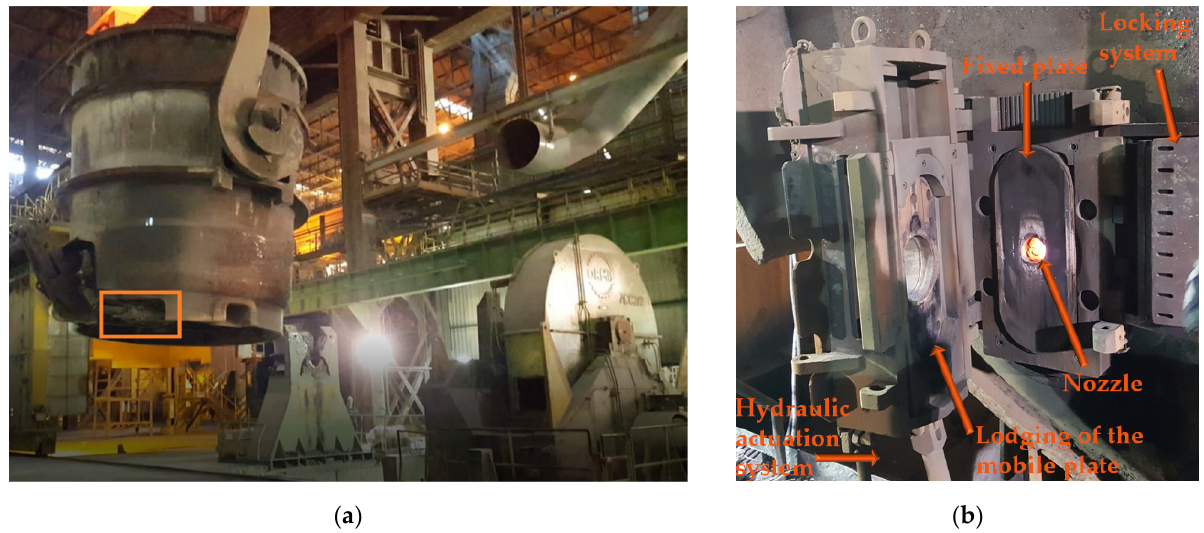
Figure 1. ( a ) the ladle during transport to the maintenance station in the steel shop; ( b ) the sliding gate adopted in the considered application.